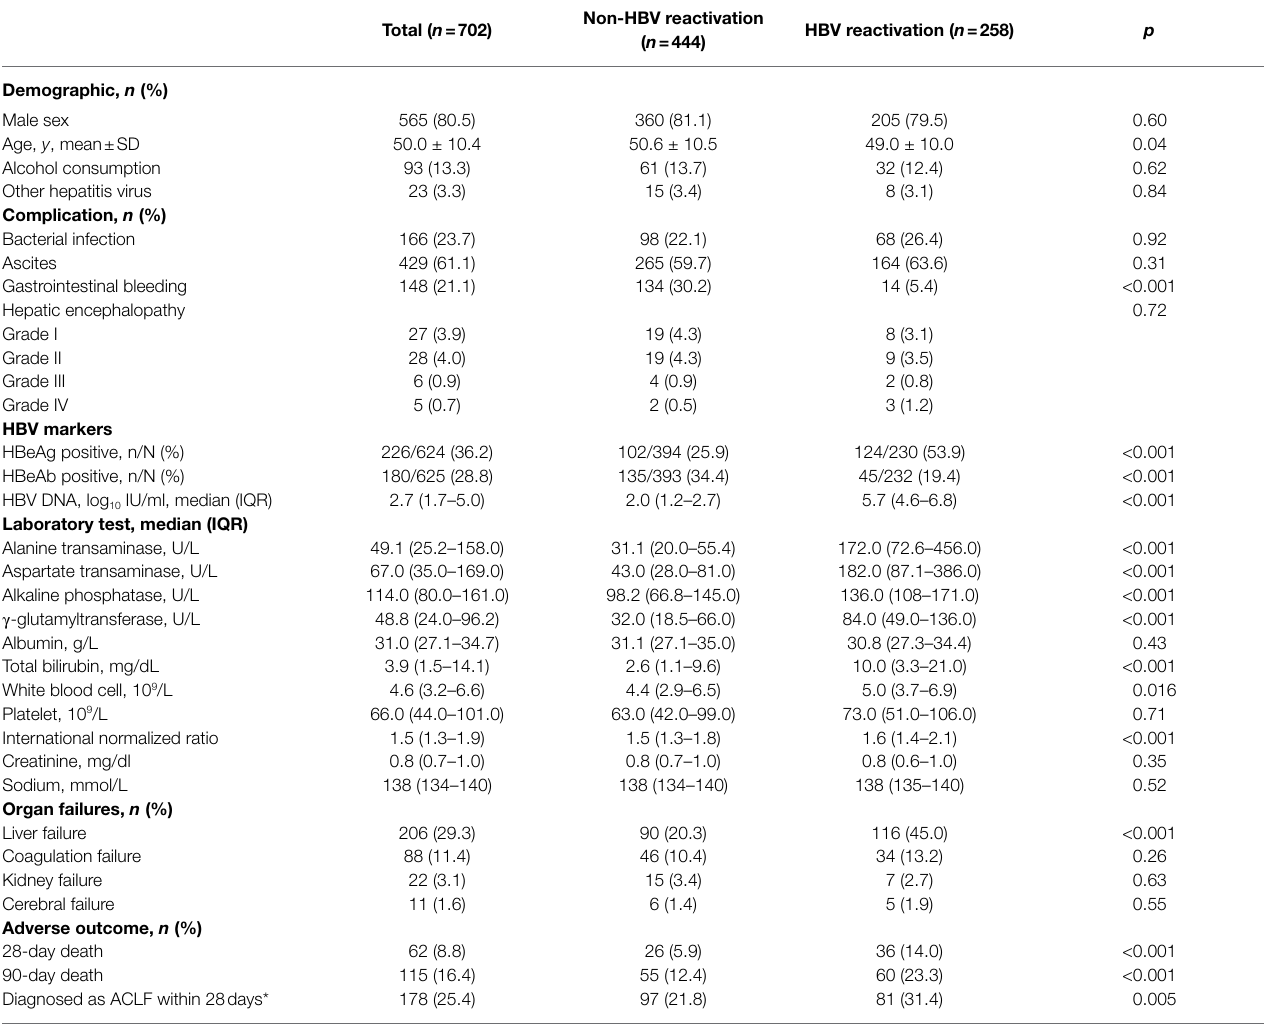
TABLE 1 | Characteristics of patients with cirrhosis between HBV reactivation and